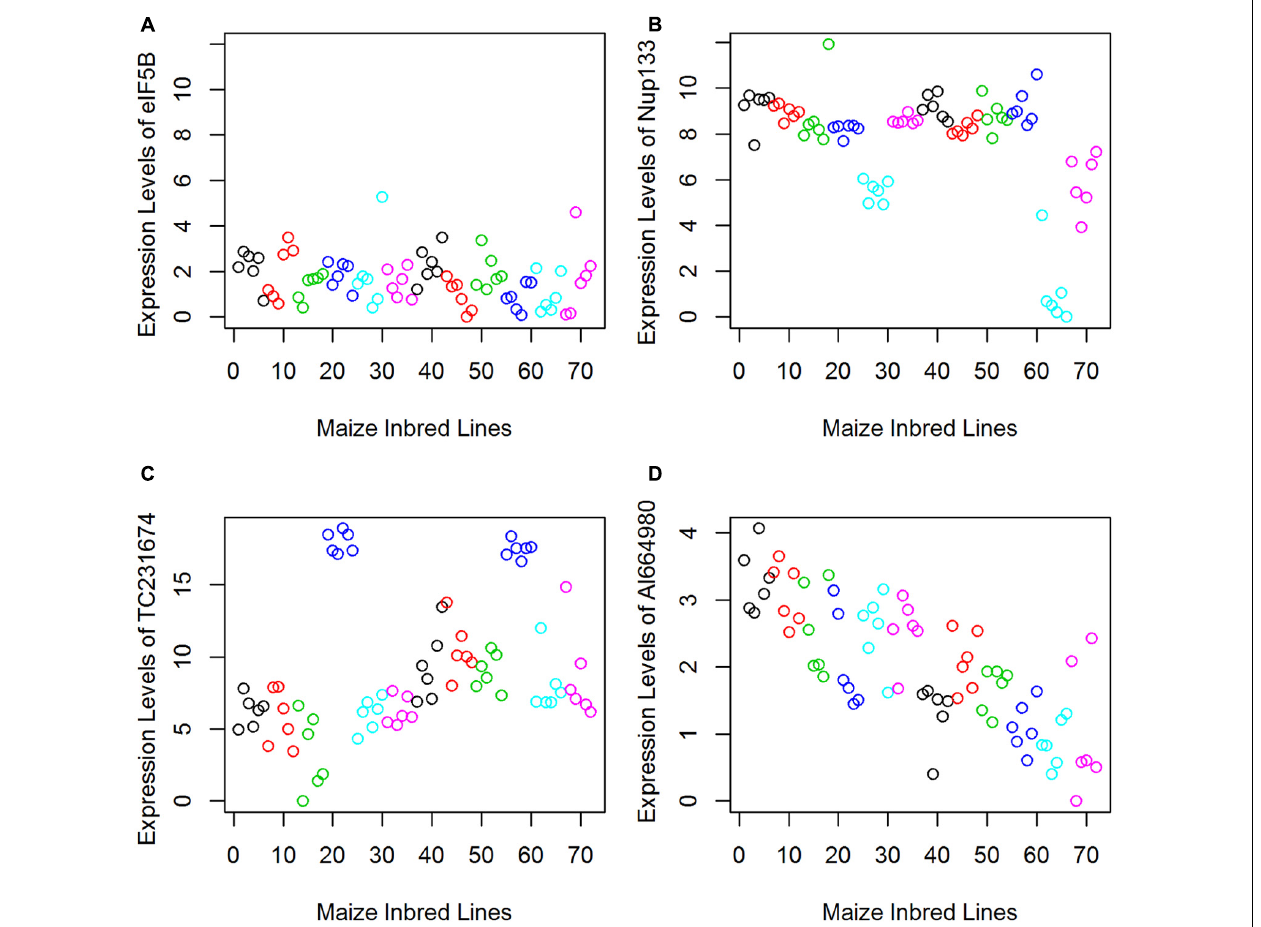
FIGURE 3 | Examples (A–D) showing that qRT-PCR gene expression values can be used as “phenotypic data” for statistical analysis. Each scatterplot represents gene expression values measured for one gene across all samples. The horizontal axis represents the 72 samples